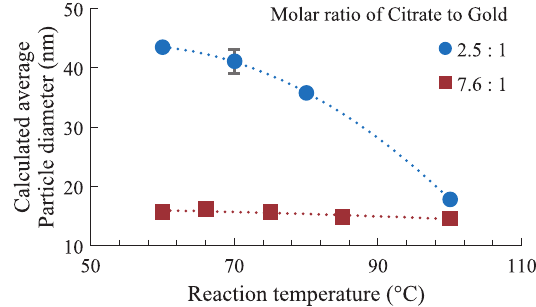
Fig. 10 The change in AuNP diameter as a function of the re- action temperature in Turkevich synthesis. The diam- eter was calculated using the method described by Haiss et al. (Haiss W. et al.,